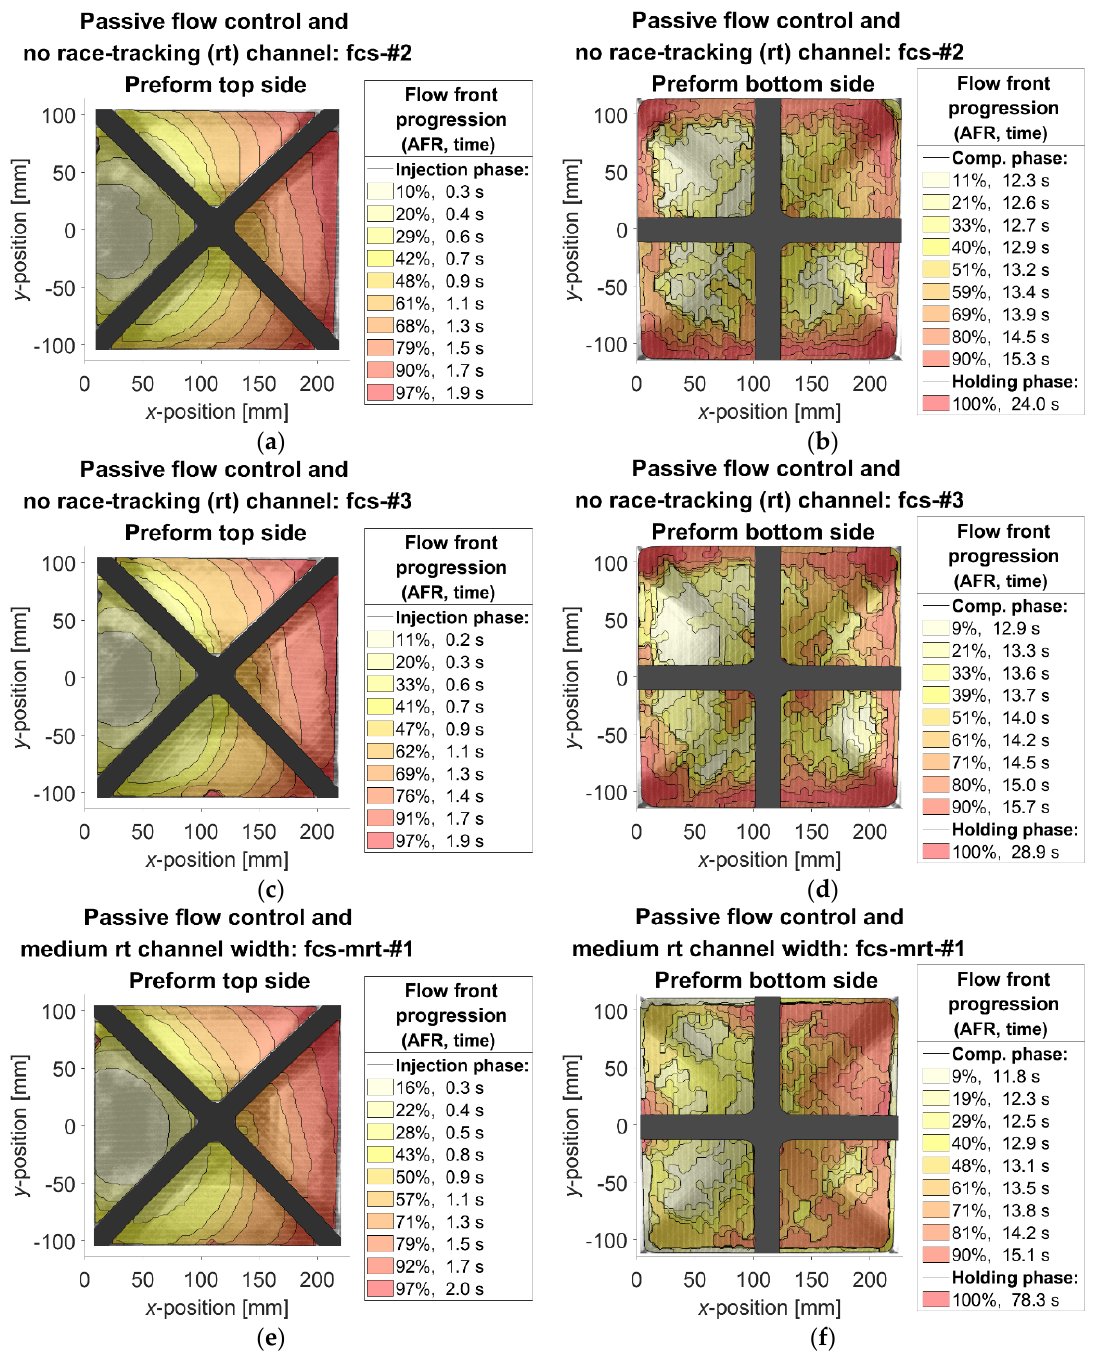
Figure A9. Flow front progression of FS-CRTM experiments of the flow control study: ( a , b ) no race-tracking (rt) channel—fcs-#2; ( c , d ) no race-tracking channel—fcs-#3; ( e , f ) medium race-tracking channel width—fcs-mrt-#1 (AFR = area filling ratio).